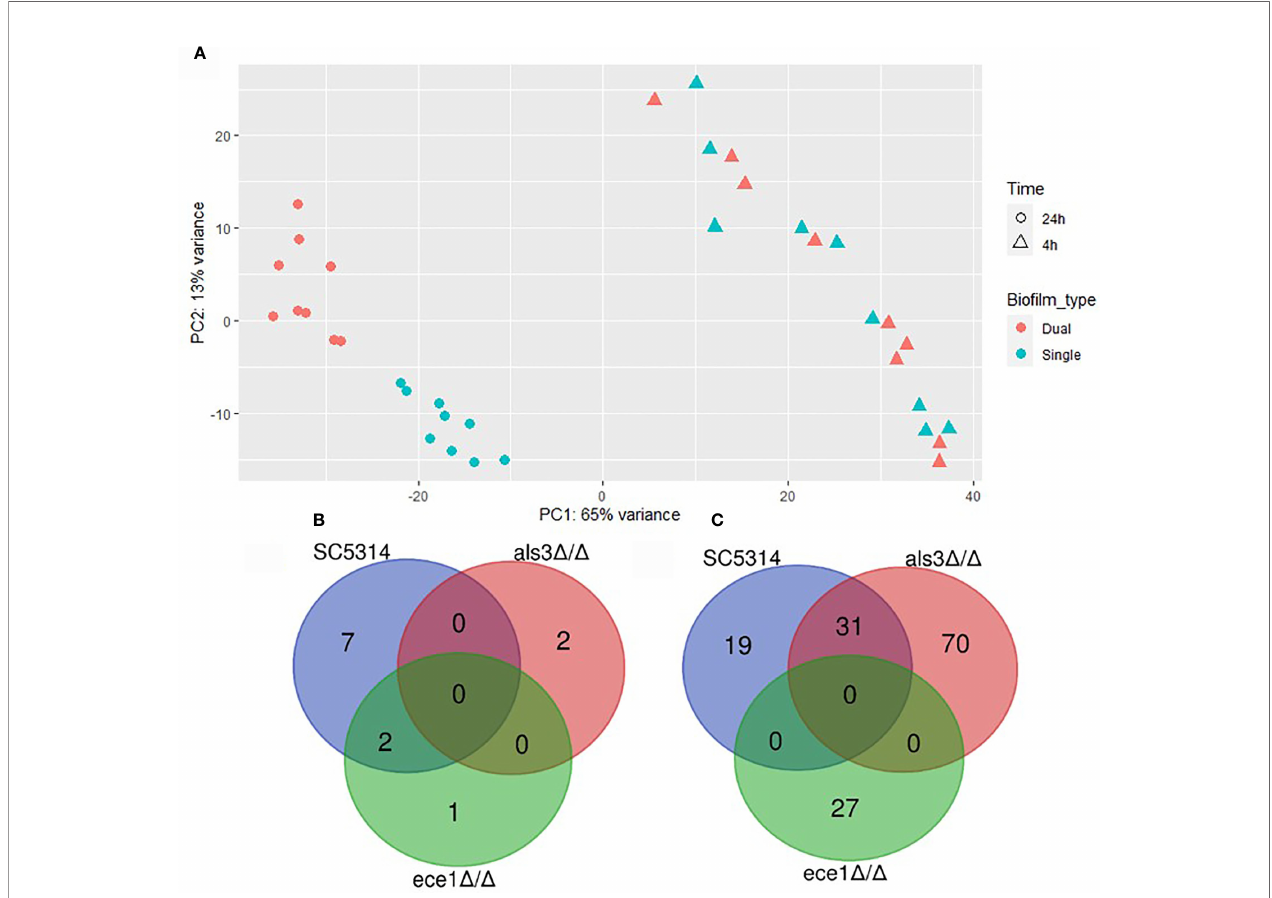
FIGURE 4 | Presence of Staphylococcus aureus determines mature bio fi lm transcriptome. (A) Principal component analysis plot shows distinct grouping of 24 h samples with the variable of largest variance along PC1 (65%) and second largest along PC2 (13%). Venn diagrams show the number of genes upregulated in 24 h (B) single ( C. albicans only) and (C) dual-species ( C. albicans and S. aureus) bio fi